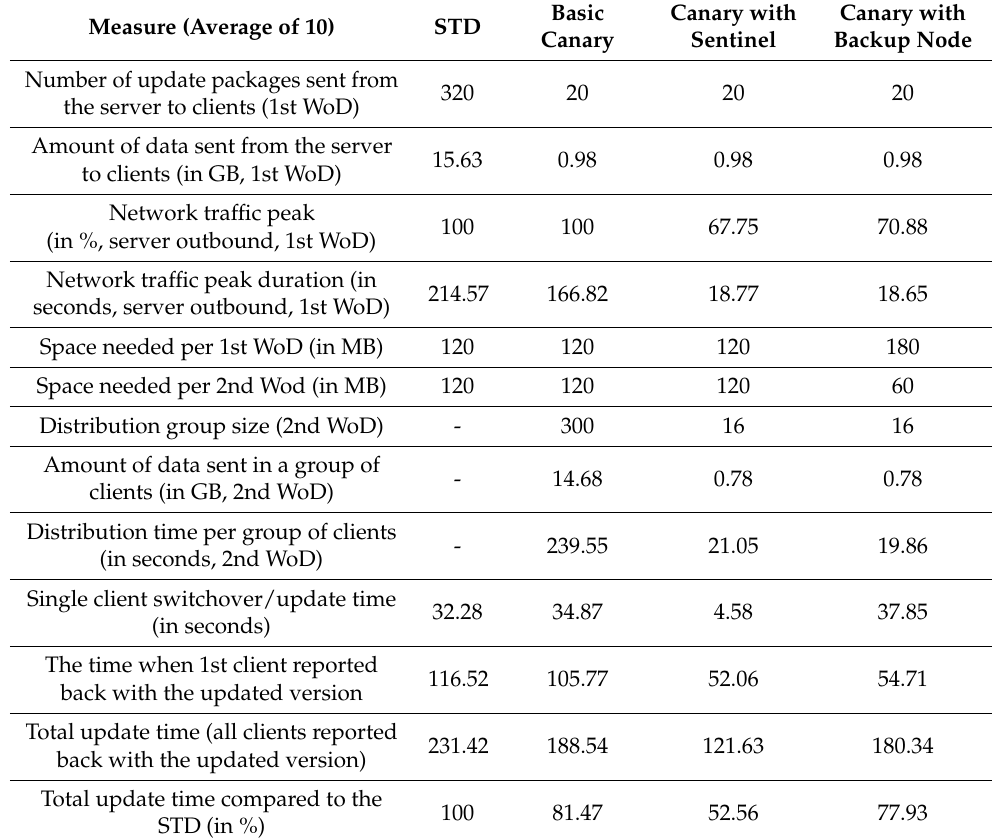
Table 3. Effects of different client deployment approaches (regular case, deployment successful, STD—standard approach, WoD—wave of